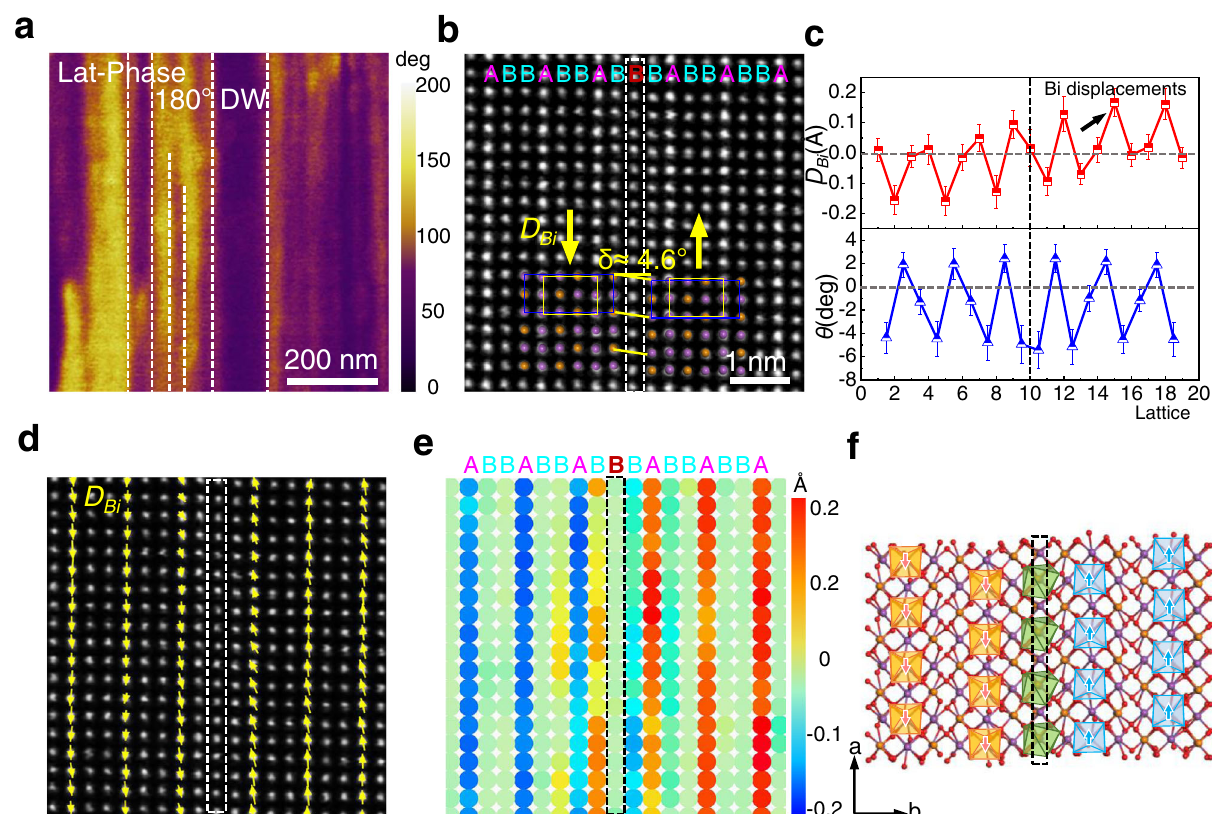
Fig. 2 | Intercalated buffer layer as 180° domain wall in Bi 2 TeO 5 single crystal. a Lateral PFM images showing the striped FE domain in Bi 2 TeO 5 . b Atomically resolved HAADF-STEM image of typical 180° domain wall. The purple and orange circles denote Bi 3+ and Te 4+ atoms, respectively. Each row is labelled as either A (Bi column) or B (mixed Bi/Te column) row accordingly. Note that additional B row is intercalated(labelledinredandhighlightedbywhitedashedrectangle)andactasa